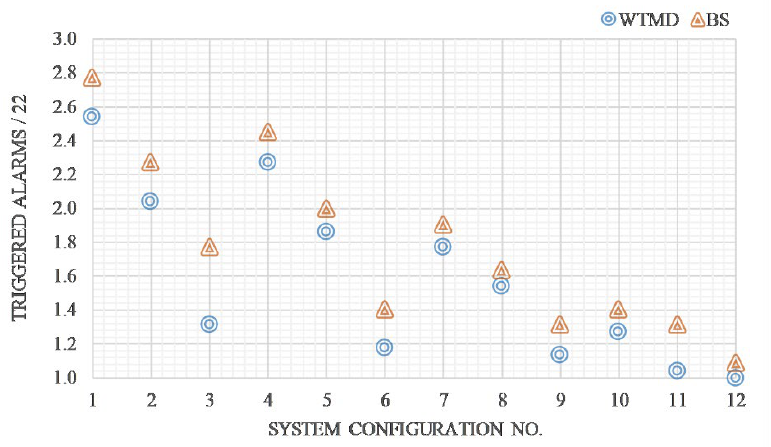
Figure 6. Ratio between the number of alarms triggered against a target value of 22 alarms/h .